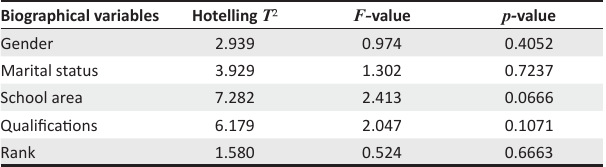
TABLE 6: Results of the five biographical variables on the Maslach Burnout Inventory subscales.